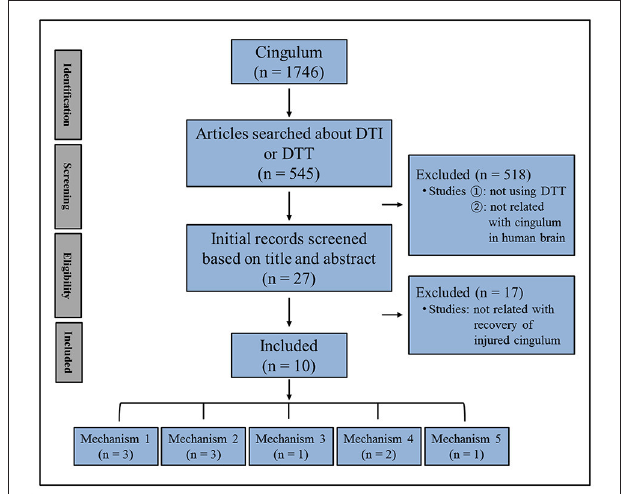
FIGURE 1 | Flow diagram of the approach used to select the studies to be